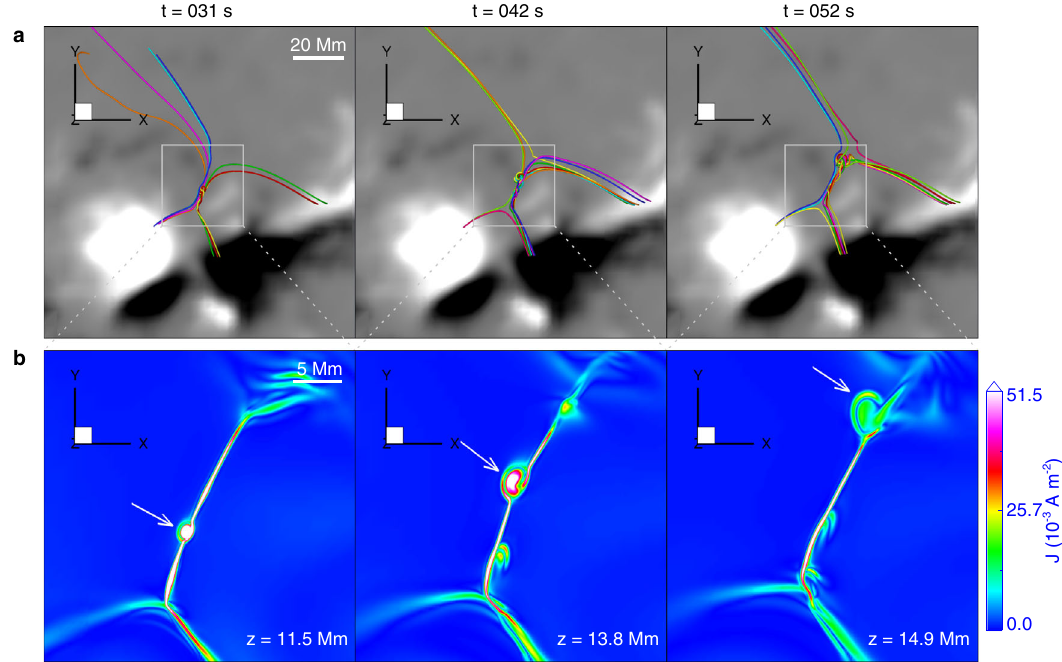
Fig. 9 Evolution of magnetic fi eld, current sheet, and plasmoids (mini fl ux ropes) during magnetic reconnection in the data-constrained MHD simulation. a Evolution of the overall magnetic structure involved in the modeled reconnection event. Note that the fi eld lines are randomly colored from column to column, and thus the same color does not indicate the same fi eld line. The background image is the longitudinal magnetic fi eld at 08:00 UT observed by SDO/HMI. b Distribution of electric current density at three selected heights and times in the current sheet. The heights are chosen at which the mini fl ux rope is sliced at its middle, i.e., the plasmoid is seen most clearly. The white arrows indicate the biggest